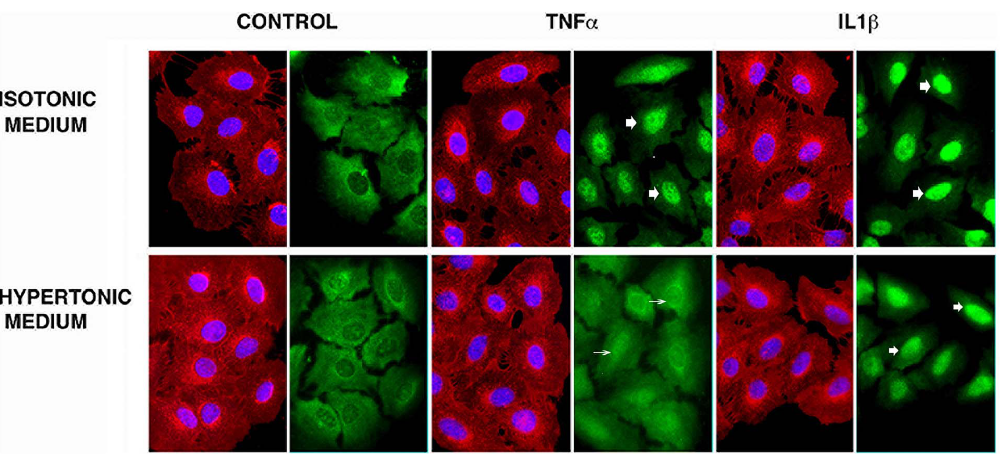
Figure 3. HOsm inhibits translocation of NF- k B into the nucleus induced by TNF a stimulation but not by IL-1 b stimulation. Indirect immunofluorescent staining was used to examine the intracellular location of the p65 subunit of NF- k B following 30 minutes of TNF a or IL-1 b stimulation in the presence of isotonic (upper panels) or 400 mOsm HTS (SOR group not shown but appeared similar to HTS group). Cell structure is depicted in red (WGA glycoprotein stain), nuclei in blue (DAPI) and NF- k B in green. NF-kB translocation into the nucleus is seen in TNF a , IL-1 b treated cells in isotonic medium. Under hyperosmolar conditions, translocation (thick arrows) stimulated by TNF a (but not IL-1 b ) is diminished (thin arrows). This figure is representative of three separate experiments. The bottom panel shows that HOsm does not significantly affect cell viability. Viabilty of pulmonary epithelial cells measured by MTTassay (absorbance) at 18 hours in the presence of 400 mOsm HTS or SOR. Cells were killed by heat treatment, at 90 ˚ Cfor 30 minutes prior to assay.